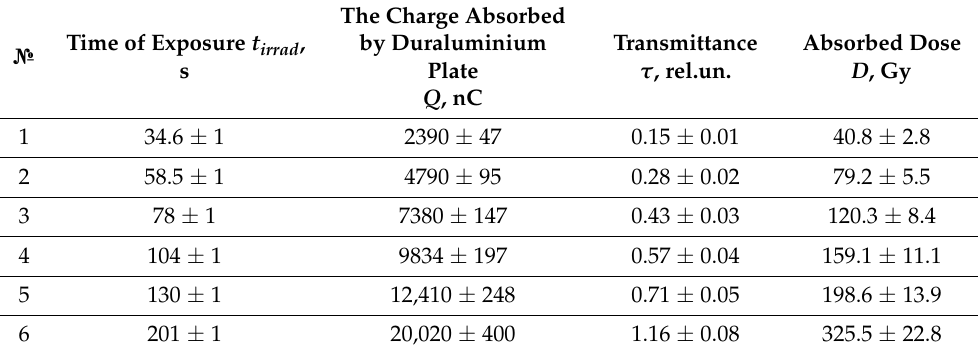
Table 1. Dosimetric solution